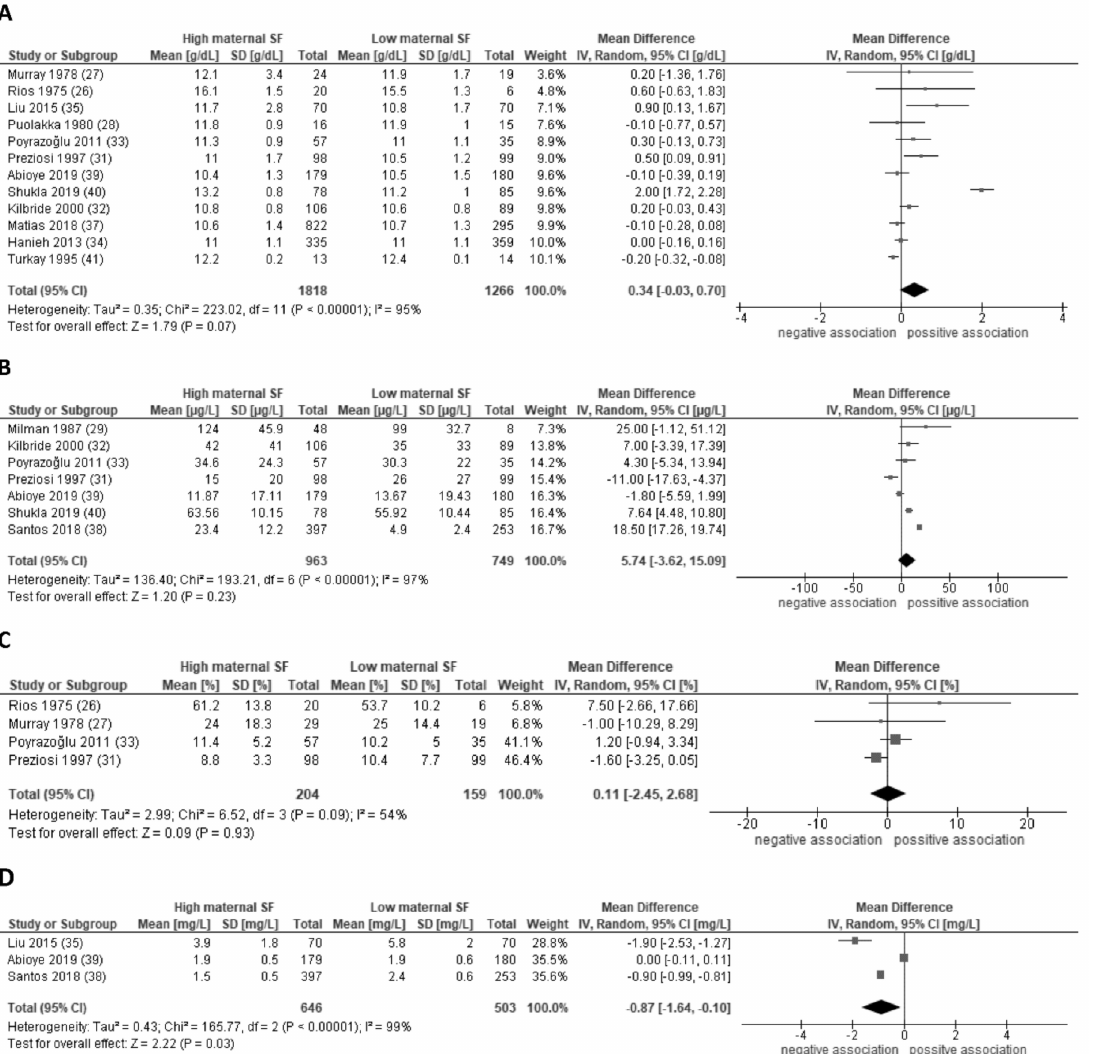
Figure 2. Forest plot of the associations of maternal serum ferritin levels during pregnancy with child hemoglobin concen- trations ( A ), child serum ferritin concentrations ( B ), child transferrin saturation ( C ), and child soluble transferrin receptor concentrations ( D ). Random-effect meta-analysis showing the pooled mean difference child hemoglobin concentrations comparing high and low maternal serum ferritin in pregnancy. CI, confidence interval; IV, inverse variation; SF, serum ferritin; DF, degrees of